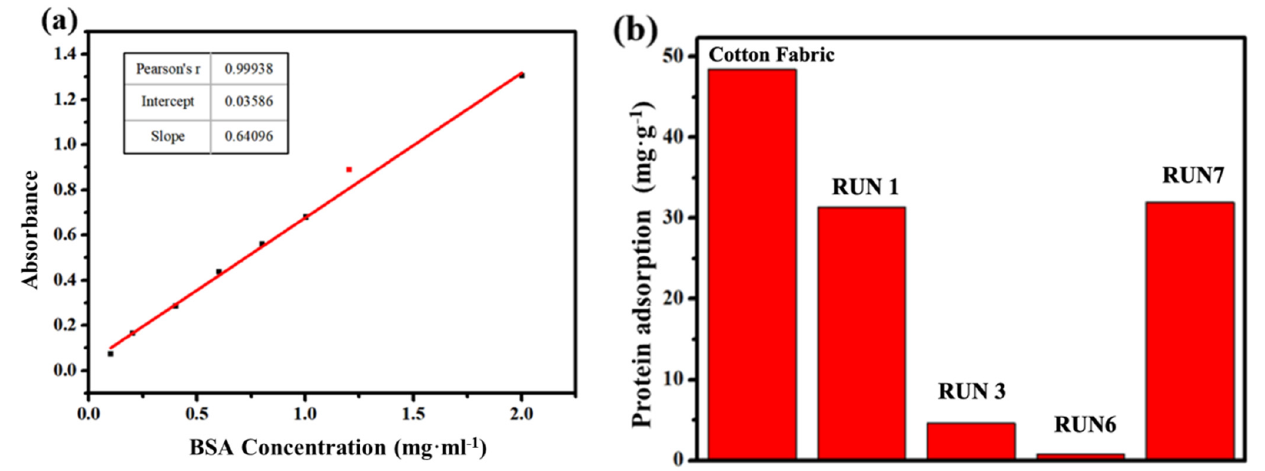
Figure 7. UV ‐ visible spectrophotometer analysis: ( a ) protein (BSA) adsorption standard curve; ( b ) protein adsorption behavior of cotton fabric (mg/g).